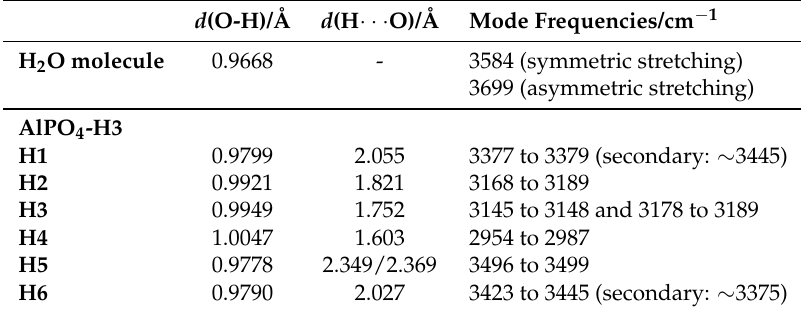
Figure 4. Computed IR ( top ) and Raman ( bottom ) spectra in the frequency range of O-H stretching vibrations. The IR spectrum includes selected frequency labels, whereas the Raman spectrum includes labels designating the primary atomic displacements associated with the modes. Table 4. Lengths of covalent O-H bonds and hydrogen bonds in AlPO 4 -H3 and frequencies of associated O-H stretching modes. PBE-TS values of an isolated water molecule are given for